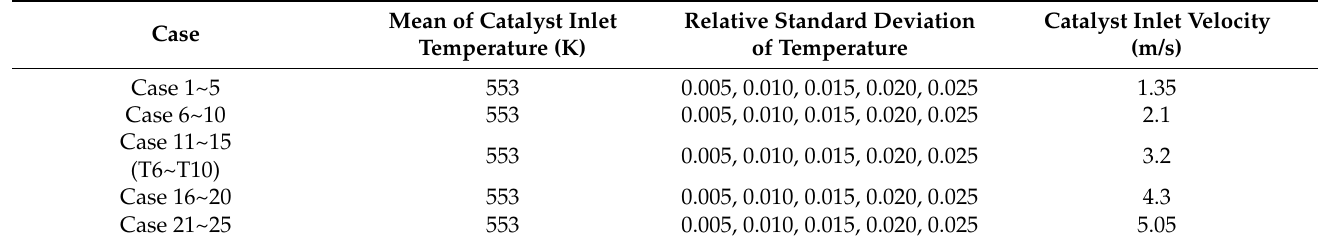
Table 3. Design of random temperature field (different averaged values of velocity).